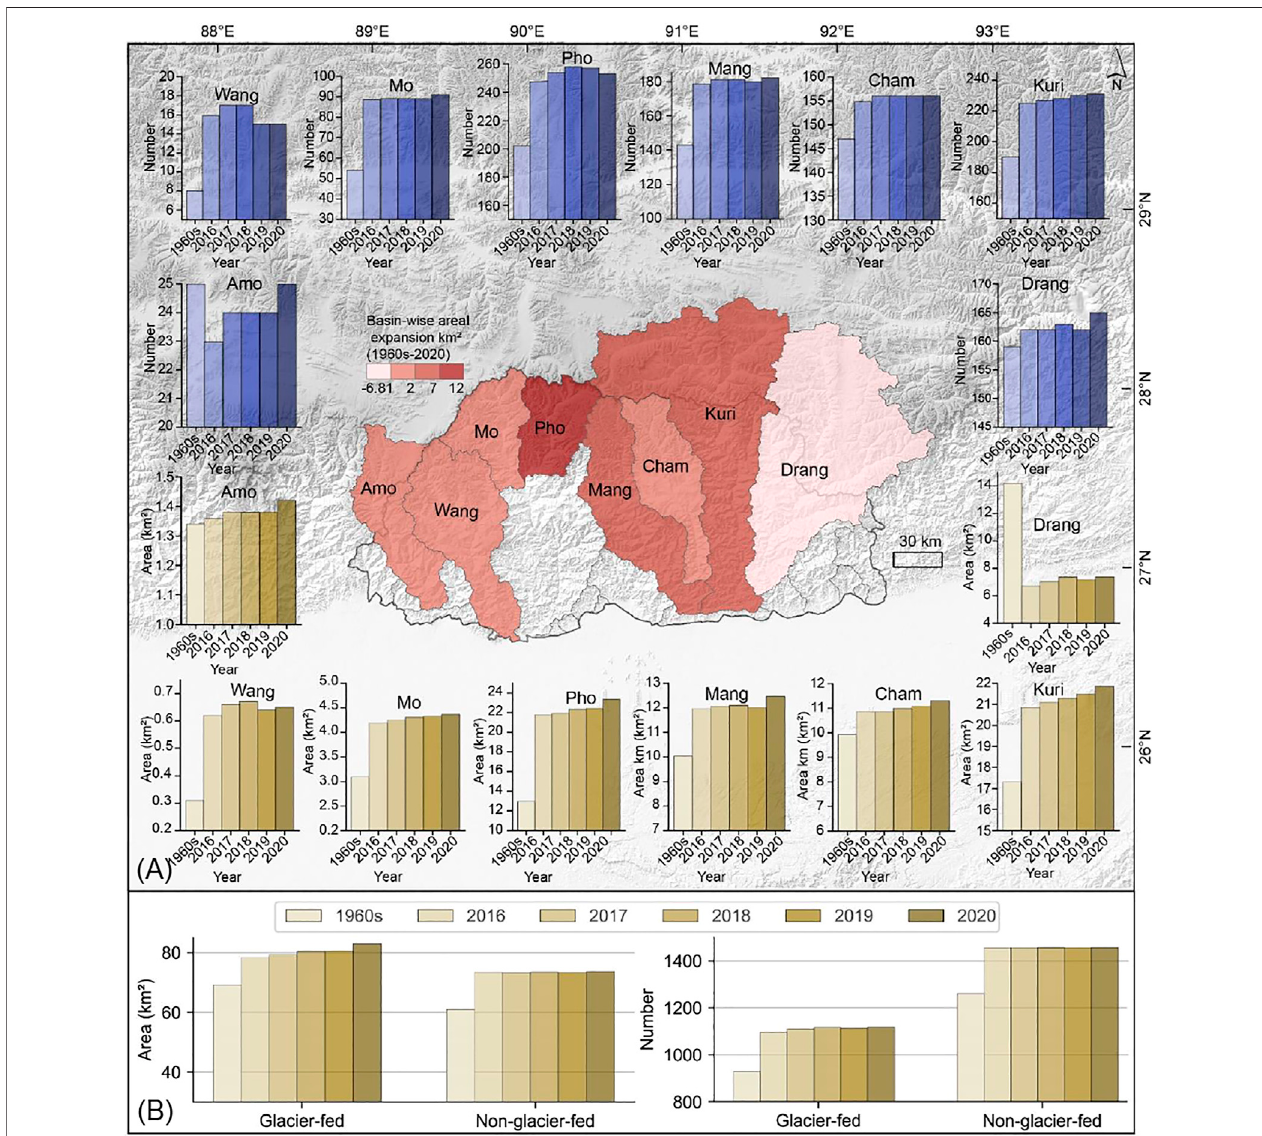
FIGURE 5 | Glacial lake changes across the eight basins for 1960s − 2016 – 2020 (A) . The map in the middle shows the absolute area change (km 2 ) for the eight basins. The glacier-fed and non-glacier-fed lake changes in the BTH for the period 1960s − 2020 (B) .